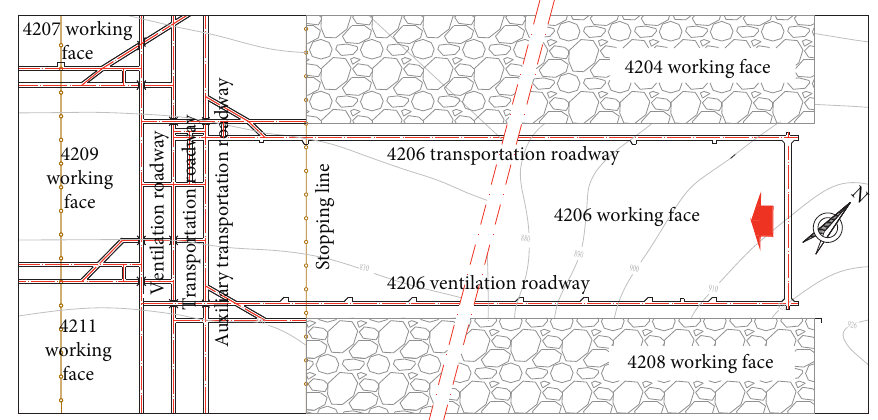
Figure 9: Layout of 4206 working face.